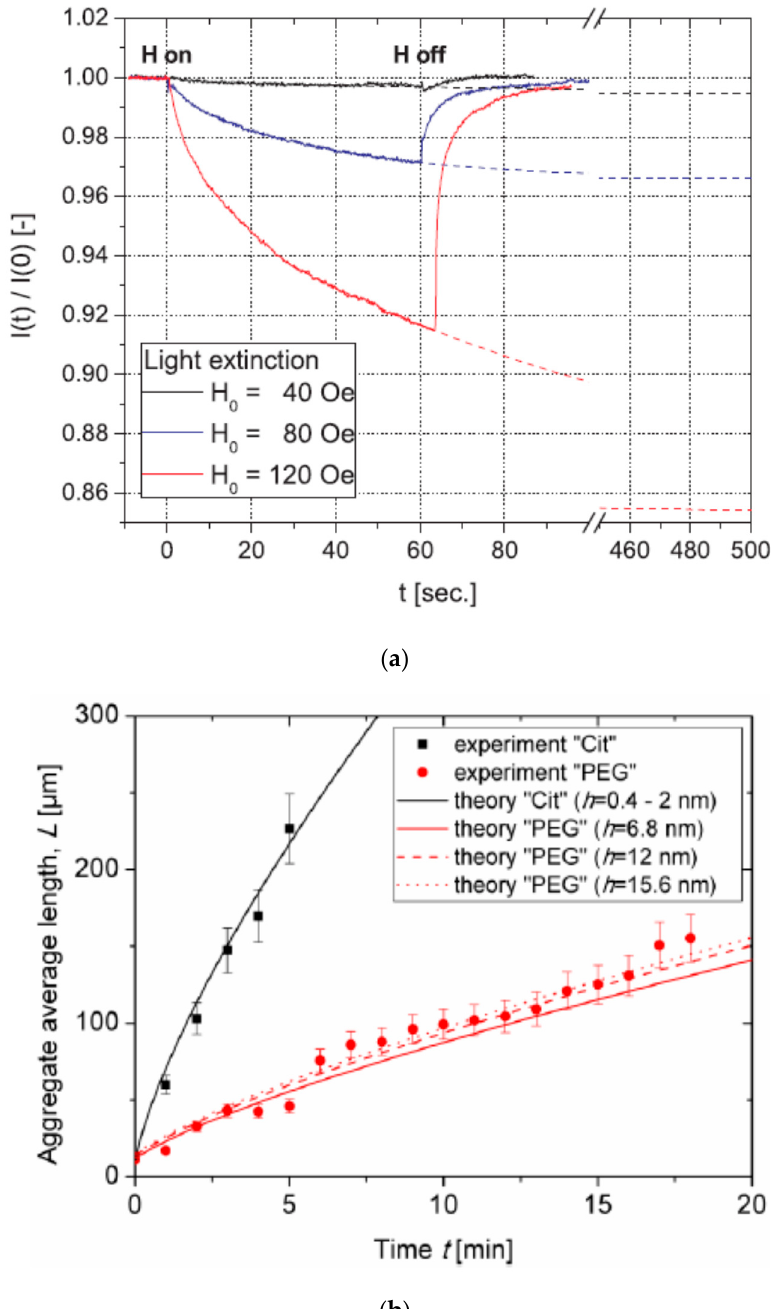
Figure 29. Kinetics of MMC magnetically induced clustering: ( a ) light extinction in 100 kHz AC magnetic field (reprinted from [271], Copyright 2020, with permission from Elsevier), and ( b ) optical microscopy in 170 Oe DC magnetic field (reprinted from [274] under Open Access license).